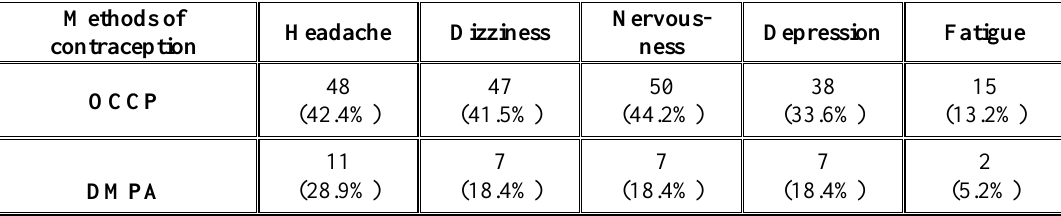
Table 3: Number of subjects (and their percentage) used different contraceptive methods showed CNS adverse effects.